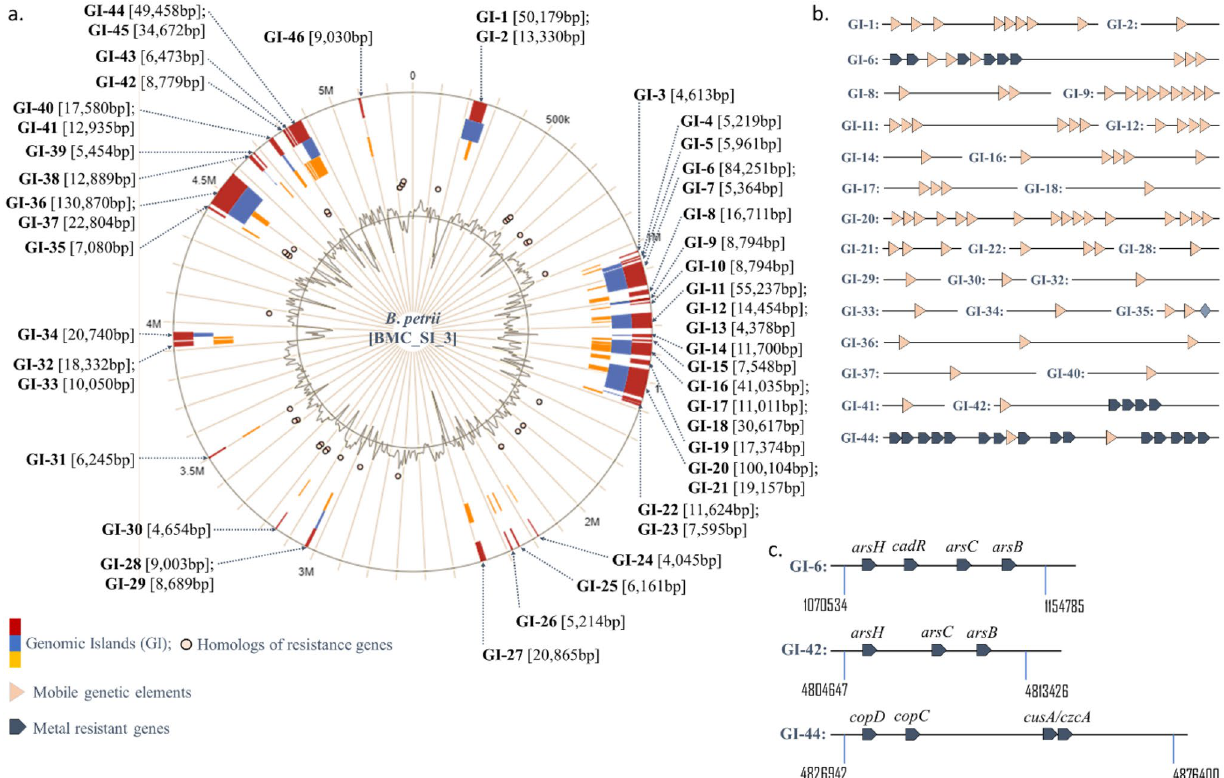
Figure 4. Genomic Islands (GIs) of BMCSI 3 genome ( a ); presence of mobile genetic elements ( b ) and metal resistant genes ( c ) were marked on the GIs (Developed from Supp. file